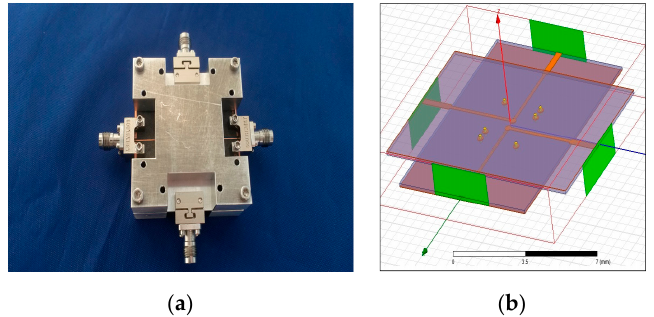
Figure 23. ( a ) Planar BGA contact pad assembly with orthogonal feed lines; ( b ) ACP between BGA pads in the overlap region.